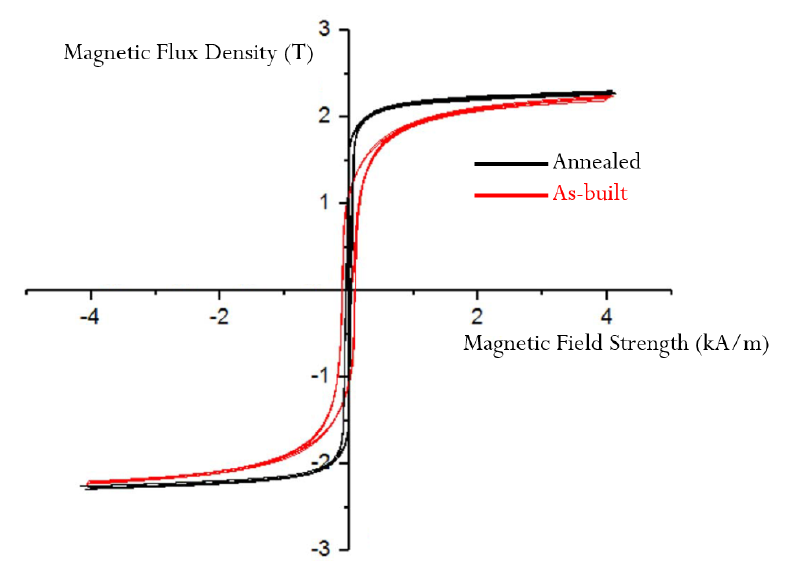
Figure 2. Comparison between quasi-static hysteresis loops of as-built FeCo and annealed FeCo. Figure is adapted from